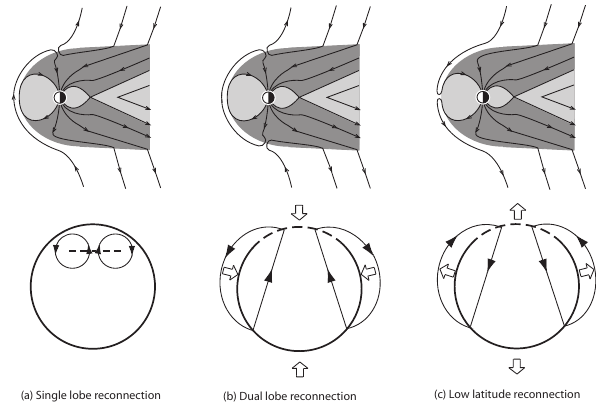
Fig. 1. Schematic representations of ionospheric convection dur- ing single lobe, dual lobe and low latitude reconnection. The upper figures represent the geomagnetic field, with the Sun to the left of the figures. The lower figures show the ionospheric convection pat- terns looking down on the Northern polar cap. The solid circle is the OCB, encircling the polar cap. The dashed portion of the OCB is the merging gap, the arrowed lines are flow streamlines and the large arrows indicate expansion or contraction of the polar cap. Lo- cal noon is directed towards the top of the